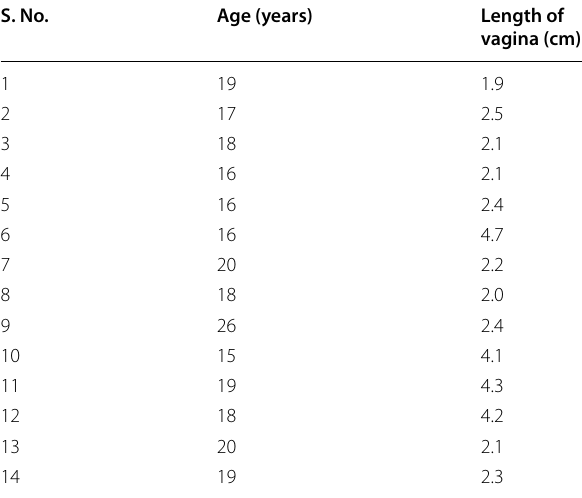
Table 3 showing the length of vagina in 14 subjects S. No.